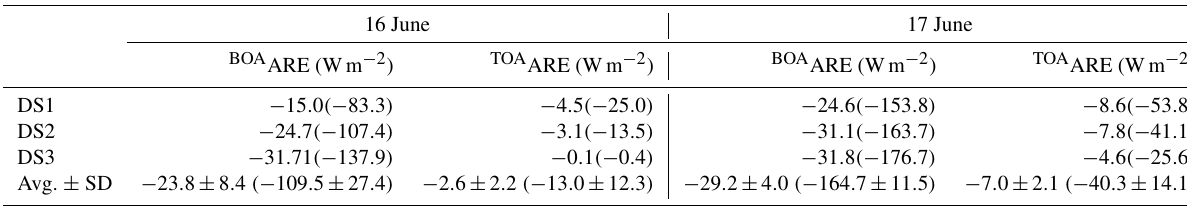
Table 8. ARE (and FE indicated between parenthesis) at the BOA and the TOA for the total (SW + LW) spectral range obtained with GAME using DS1, DS2, and DS3 as inputs for 16 and 17 June 2013. The averaged values and standard deviation are also